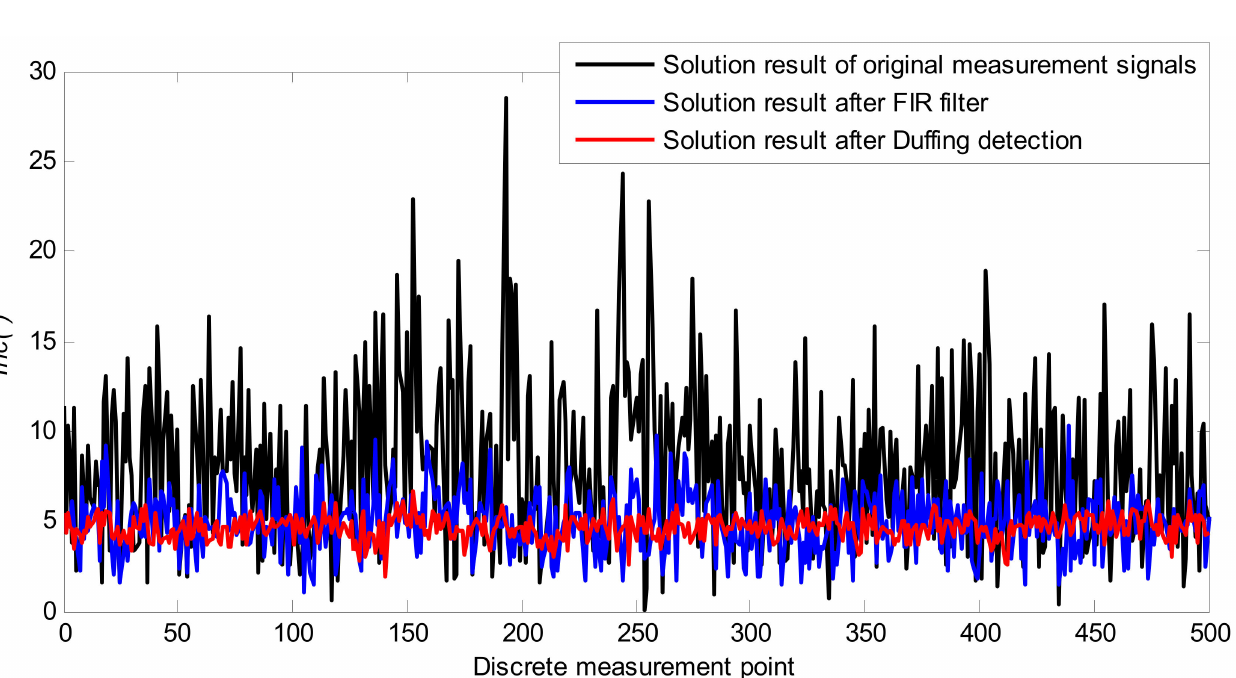
Figure 7. Comparison of the solution results for the